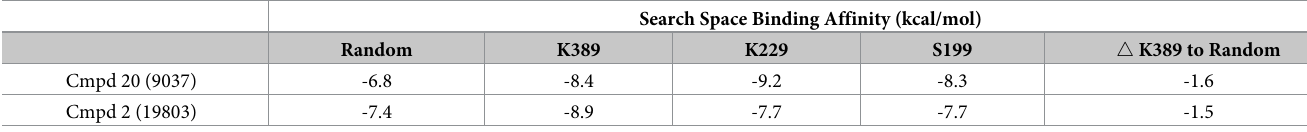
Table 1. Autodock calculations for binding to NAMPT search